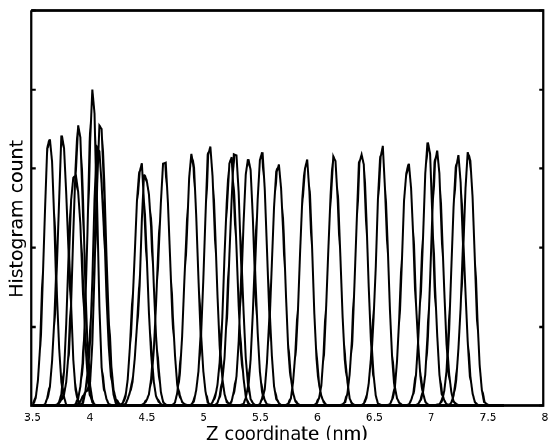
Figure 6. Distribution of the distances taken by the KRSR peptide’s center of mass from the TiO 2 surface at different fixed points during the 10 ns sampling.